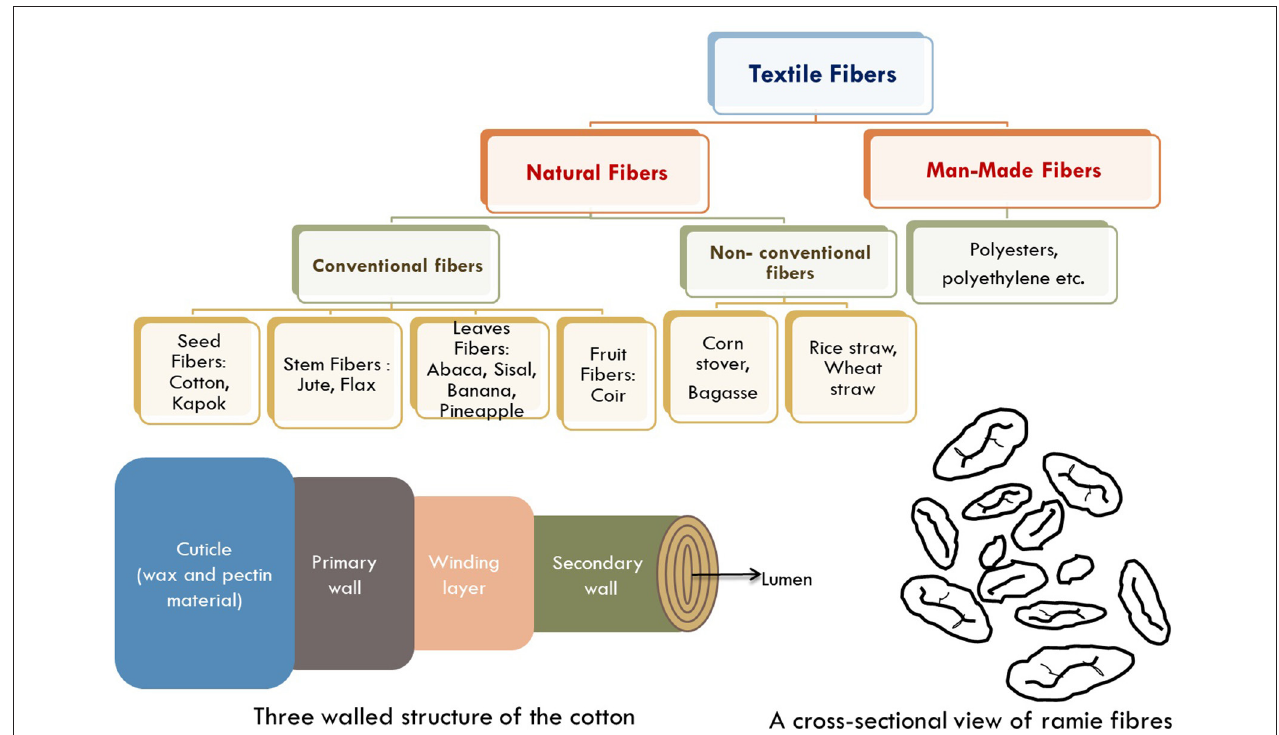
FIGURE 1 | Classification of fibers with three-walled structure of cotton and cross-section view of ramie fibers.